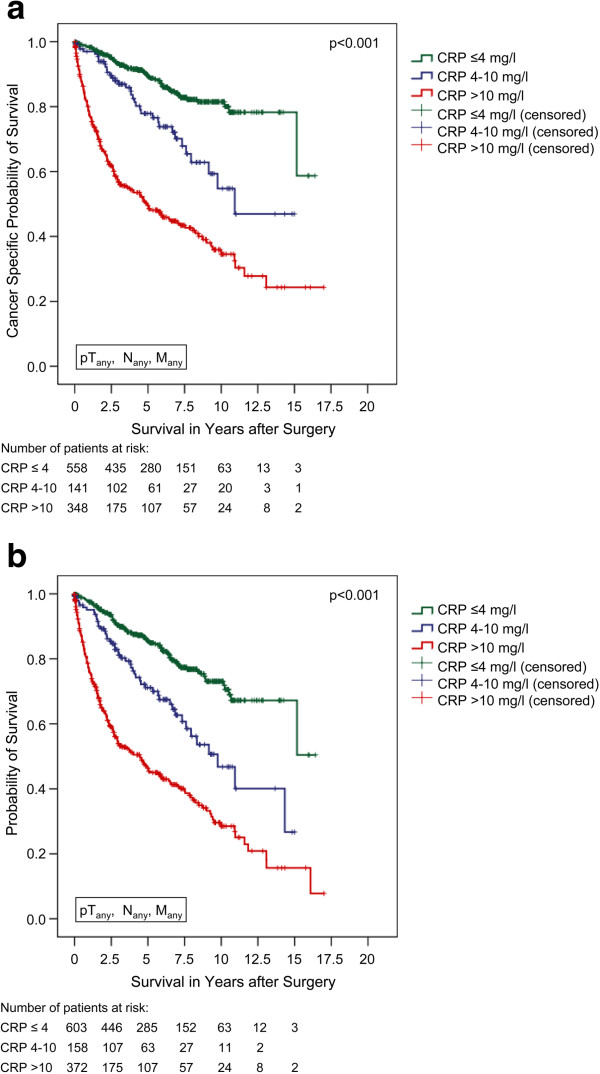
a) Cancer-specific survival (Kaplan-Meier) for all RCC patients plotted against the pre-operative CRP-group. The 5-year survival rate was 89.4%, 77.9%, and 49.5% for all evaluable patients (n = 1,047) with a CRP of ≤4 mg/l (n = 558), 4–10 mg/l (n = 141), and >10 mg/l (n = 348), respectively (p < 0.001, log rank). b) Overall survival (Kaplan-Meier) for all RCC patients plotted against the pre-operative CRP-group. The 5-year survival rate was 85.5%, 71.1%, and 46.3% for all evaluable patients (n = 1,133) with a CRP of ≤4 mg/l (n = 603), 4–10 mg/l (n = 158), and >10 mg/l (n = 372), respectively (p < 0.001, log rank).